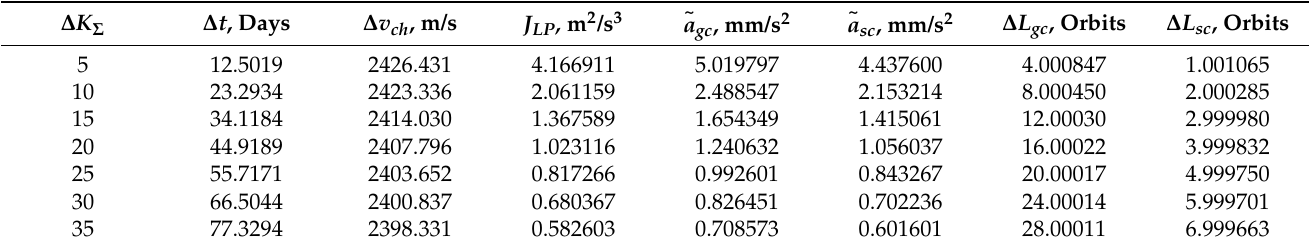
Table 1. The main parameters of the optimal trajectories with an optimal junction point.